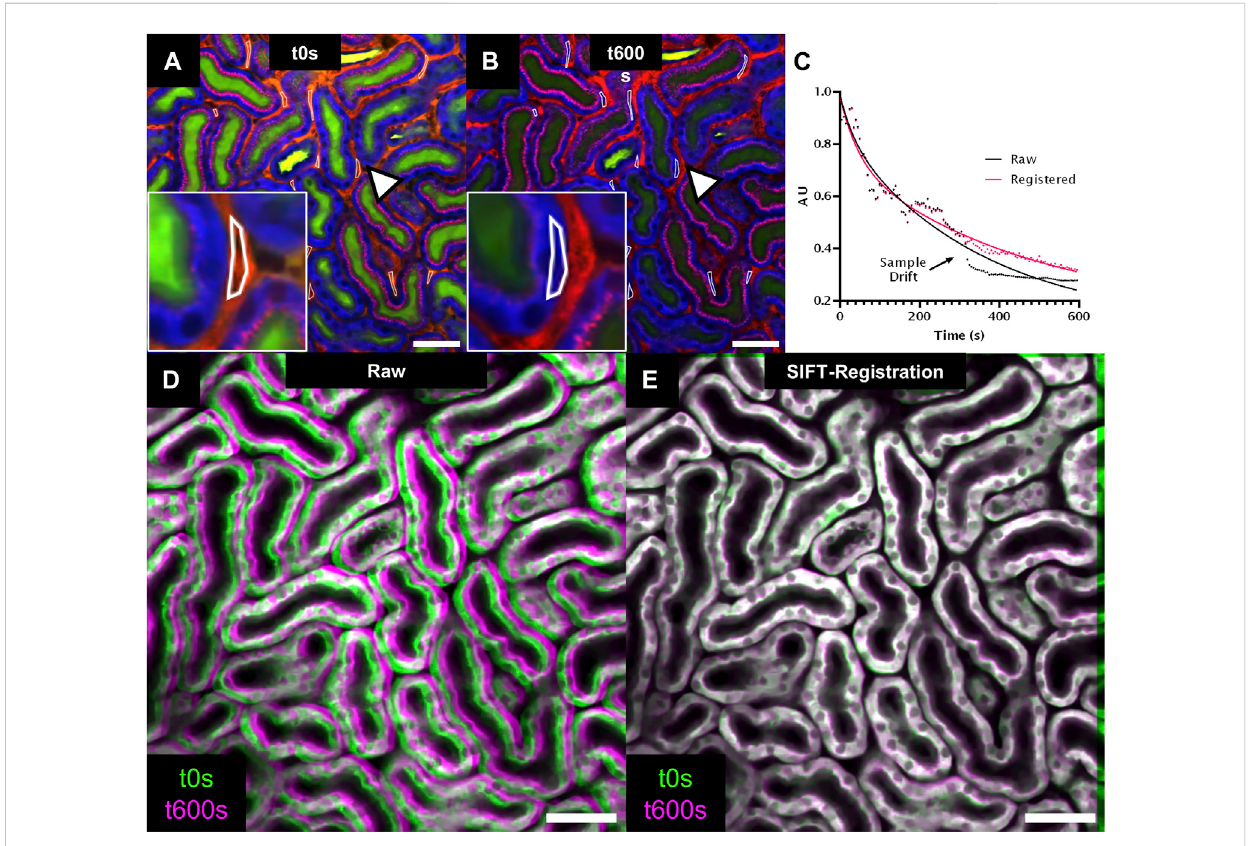
FIGURE 3 2Dregistration oftime series(Tseries) withSIFTfor bolustrackingexperiment. (A,B) Intravital 2-photonmicroscopy images extracted fromaTseries acquired in a wildtype mouse kidney after injection of a FITC-Dextran 4kDa bolus injection (green). Images were extracted at time points t0s and t600s from the Tseries. Tubule epithelium is visualized in blue through tubule auto fl uorescence and peritubular vasculature and albumin uptake in proximal tubules is labeled in red through Alexa594-albumin (Table1). Multiple regions of interest (ROI, arrowhead, inset) are placed onto peritubular capillaries to assess vascular FITC-Dextran 4kDa fl uorescence intensity over time. Note displacement of ROIs at t600s due to sample drift (arrowhead, inset, (B) . (C) Time-intensity plot (dotted line) and non-linear fi tting (continuous line) of vascular FITC-Dextran 4kDa fl uorescent decay assessed in raw (black)andSIFT2Dregistereddata(red). (D,E): Overlayoftubuleauto fl uorescencesignal fromimagetimepointst0s(green)and t600s(magenta)forraw (D) and SIFT 2D registered data (E) provides visual con fi rmation of sample drift compensation. Scale bars = 50 µm Temporal resolution =